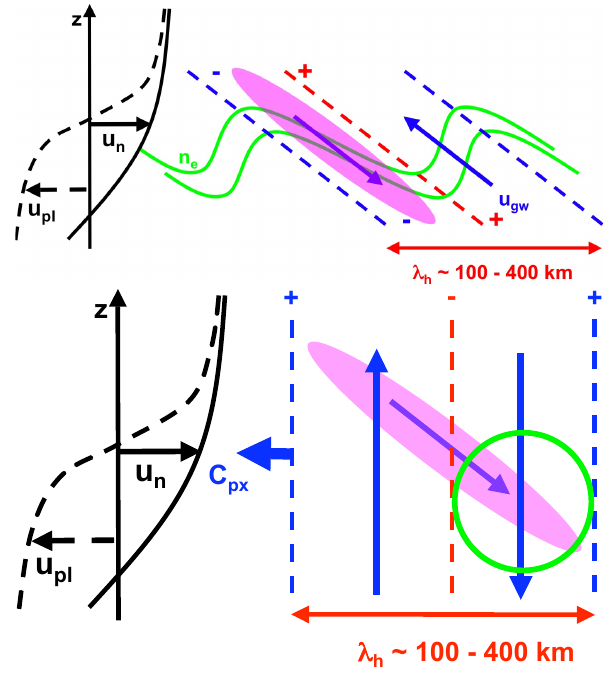
Fig. 6. Profiles of neutral wind ( U n , solid black line) and plasma motion ( U pl , dashed black line) at the bottomside F layer (left) along the dip equator expected under ESF and RTI seeding con- ditions. At top right are shown surfaces of constant electron density (green) due to an upward- and westward-propagating GW. Max- imum upward and downward displacements are shown with blue and red dashed lines, respectively, GW neutral velocities are shown with blue arrows, and the region with the maximum electron den- sity gradient is shown in pink. At bottom right are shown the region of enhanced electron density accompanying the GW propagating upward and westward and the corresponding maximum displace- ments and neutral velocities for a GW that is close to a turning level at which λ z = > ∞ and w 0 (cid:29) u 0 . Note that a GW near a turning level h may further enhance downward (or upward) motions without sig- nificantly impacting neutral or electron density